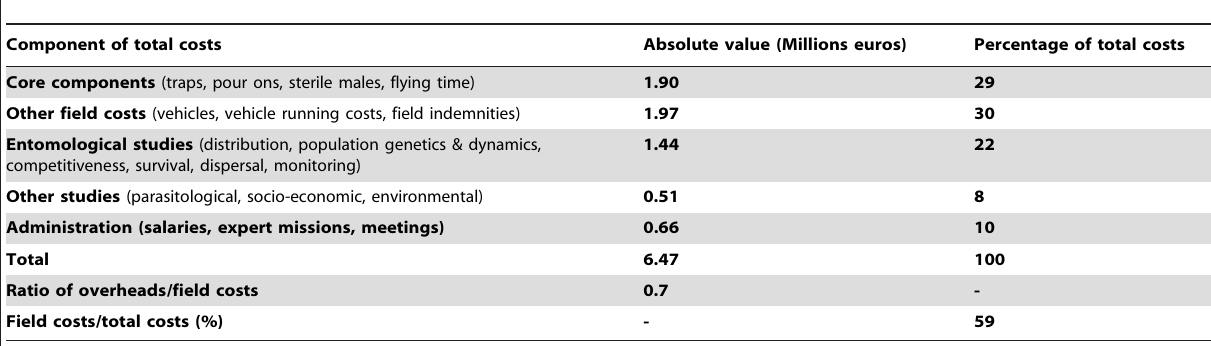
Table 2. Breakdown of total costs of the tsetse elimination project in the Niayes area.